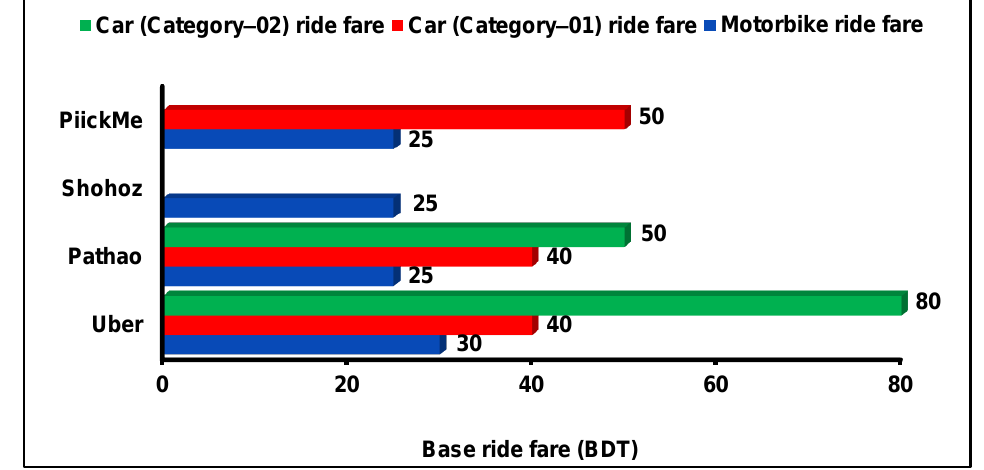
Fig. 6. Comparison based on base ride fare.